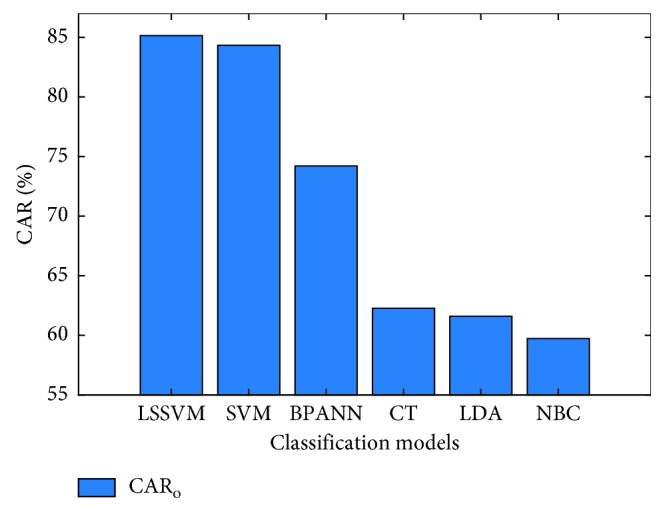
Result comparison based on CARo.